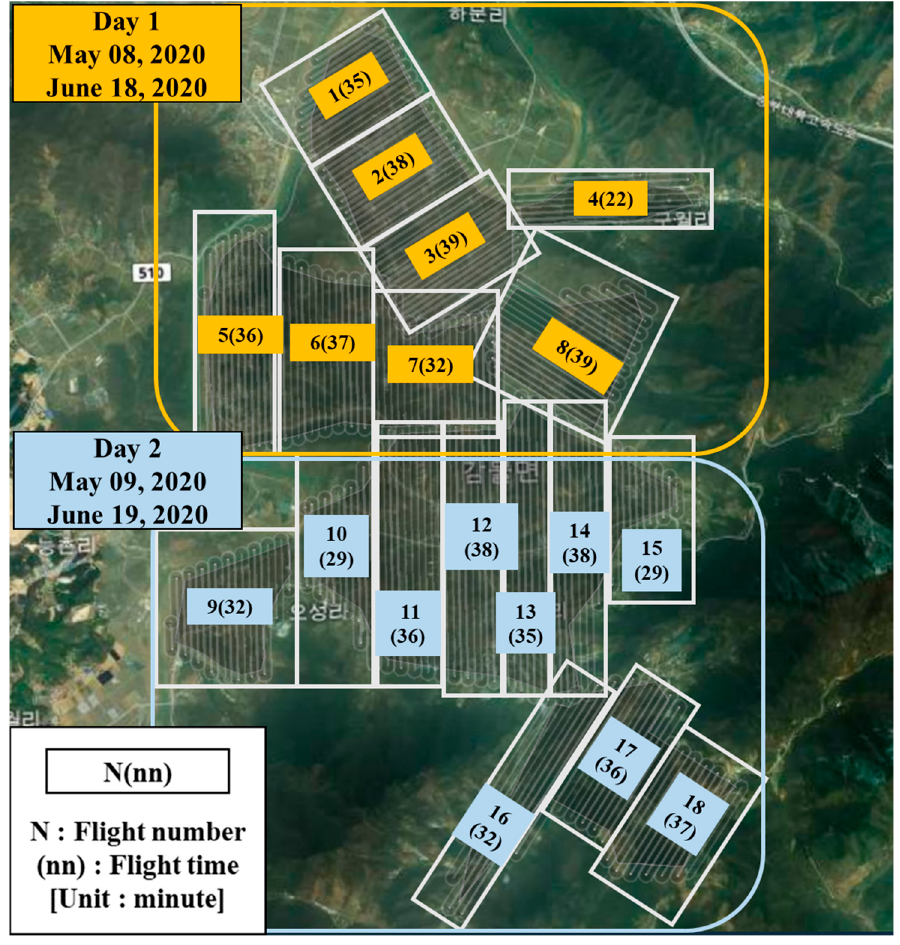
Figure 6. Pre-UAV image acquisition and flight route planning for wide-area data acquisition. Table 2. Hardware specifications of the image processing system used in this study.